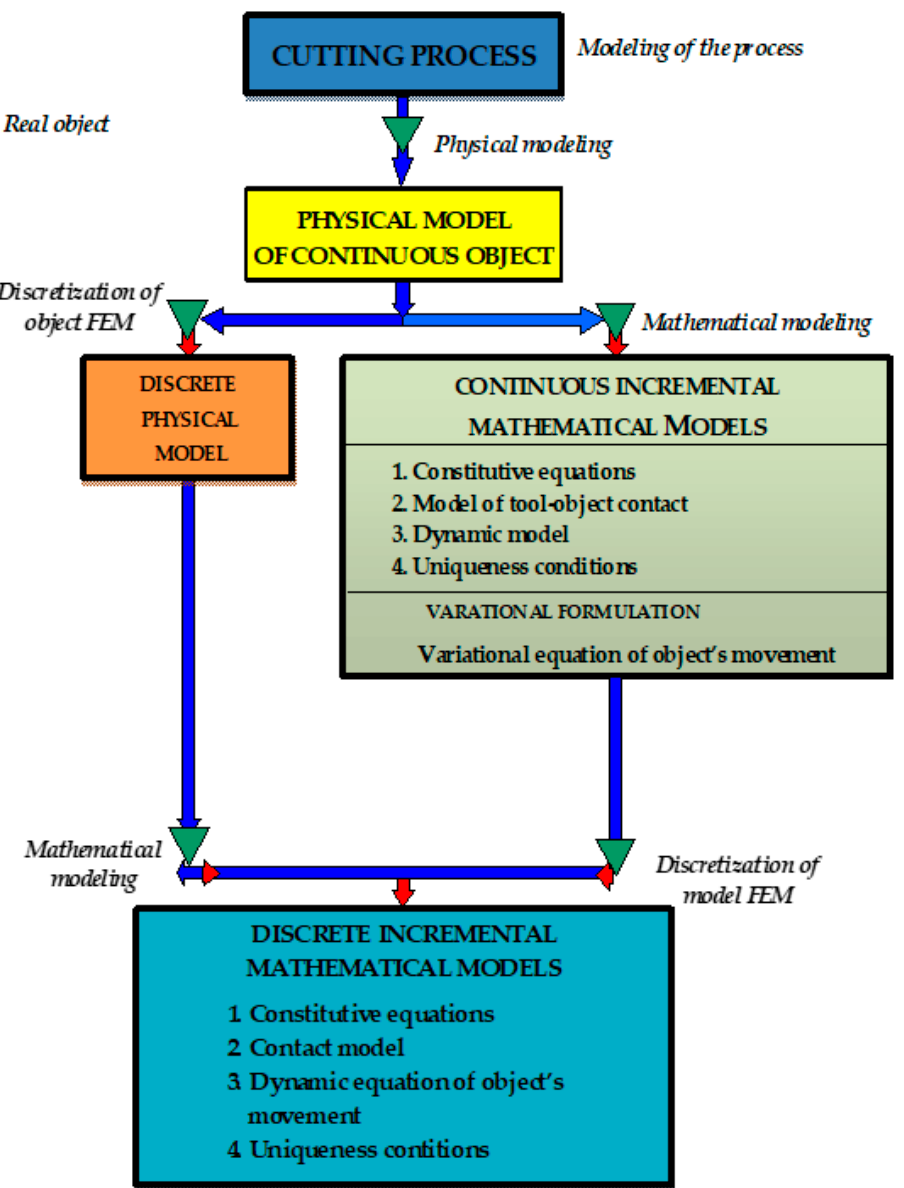
Figure 2. Flow chart of modeling the cutting process.